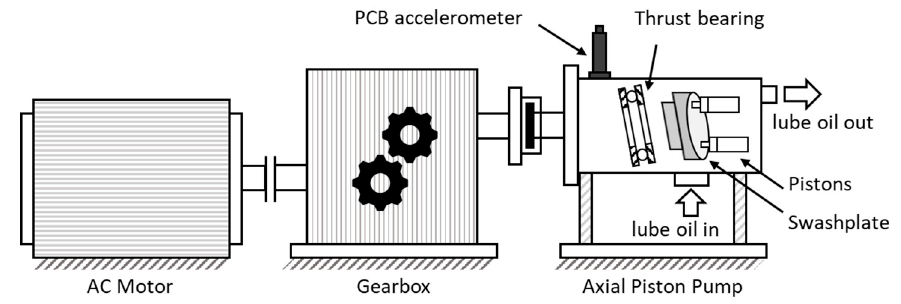
Figure 20. The swashplate axial piston pump test rig.